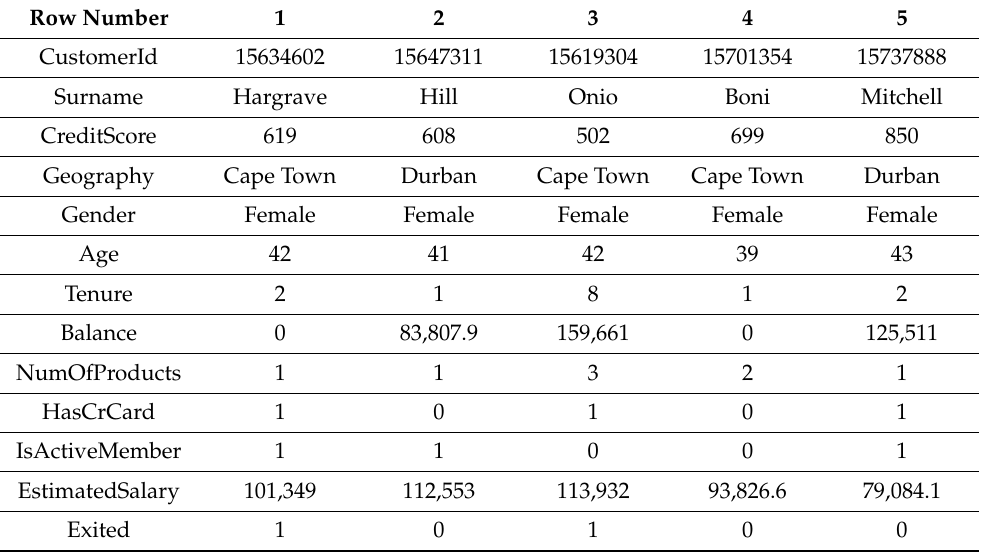
Table 2. The study’s sample